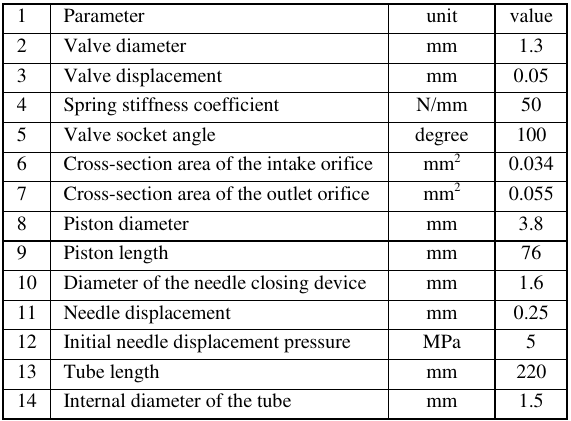
Table 1. Fuel system